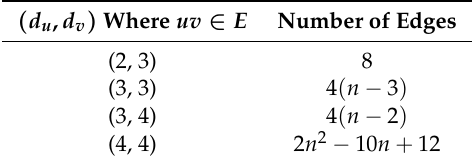
Table 3. Edge partition of SL n on the basis of degrees of end vertices of each edge.